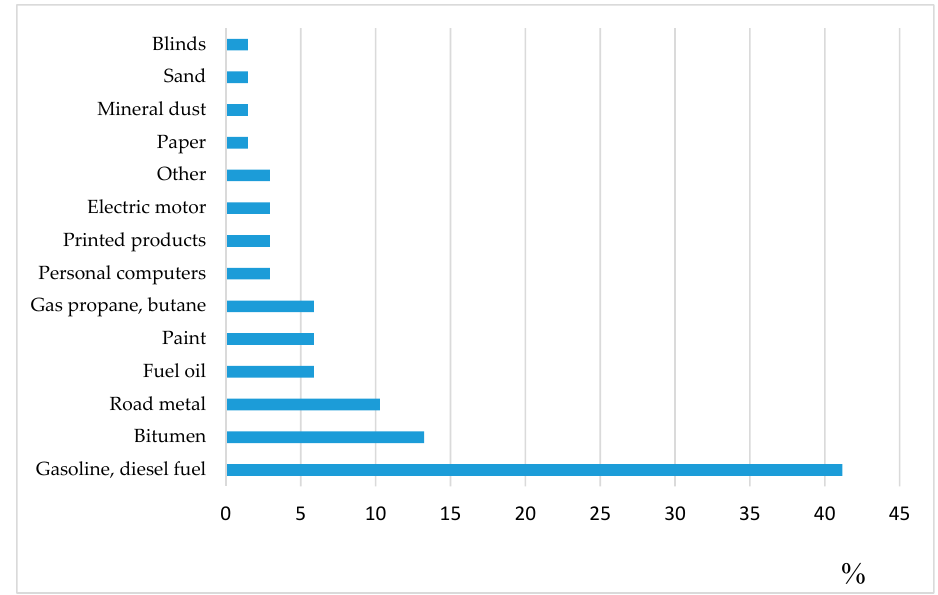
Figure 2. Goods purchased by customers by non-price criteria in 2019. Source: compiled by the authors according to the data of the analytics module (Bi.prozorro 2019). Table 2. Level of competition for selected items, depending on the use of non-price criteria.